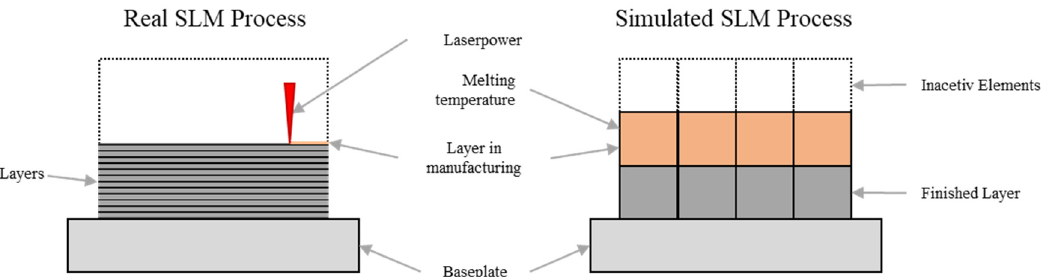
Figure 6. Real and simulated SLM setup in comparison.